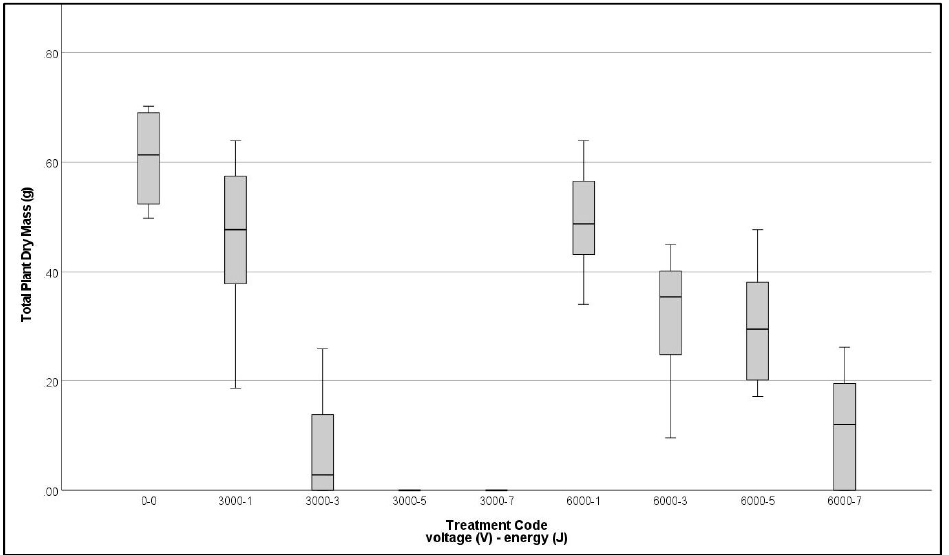
Figure 5. Clustered boxplot of total plant dry weight per bag of Lolium multiflorum 15 days after treatment by applied voltage and target energy.